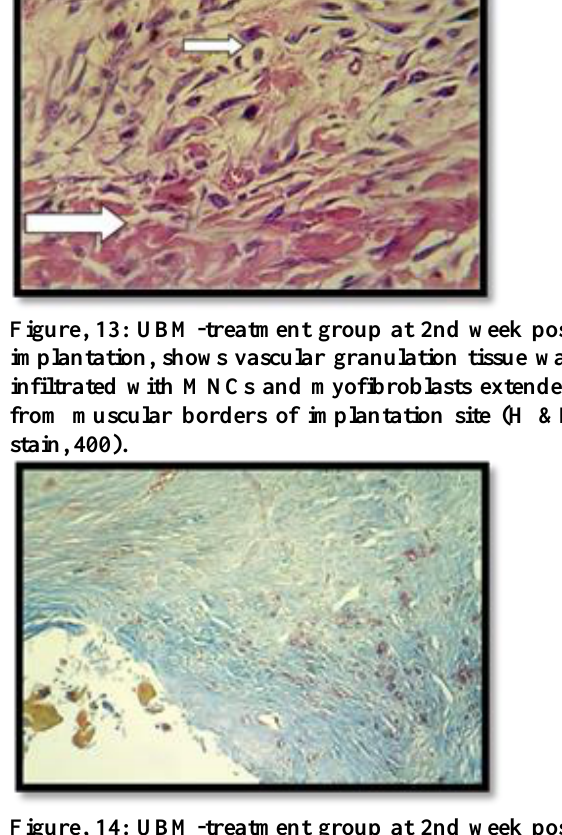
Figure, 14: UBM-treatment group at 2nd week post implantation shows deposition of newly form collagen fibers mainly around tissue debris (long arrow) (Mallory stain, 100X).